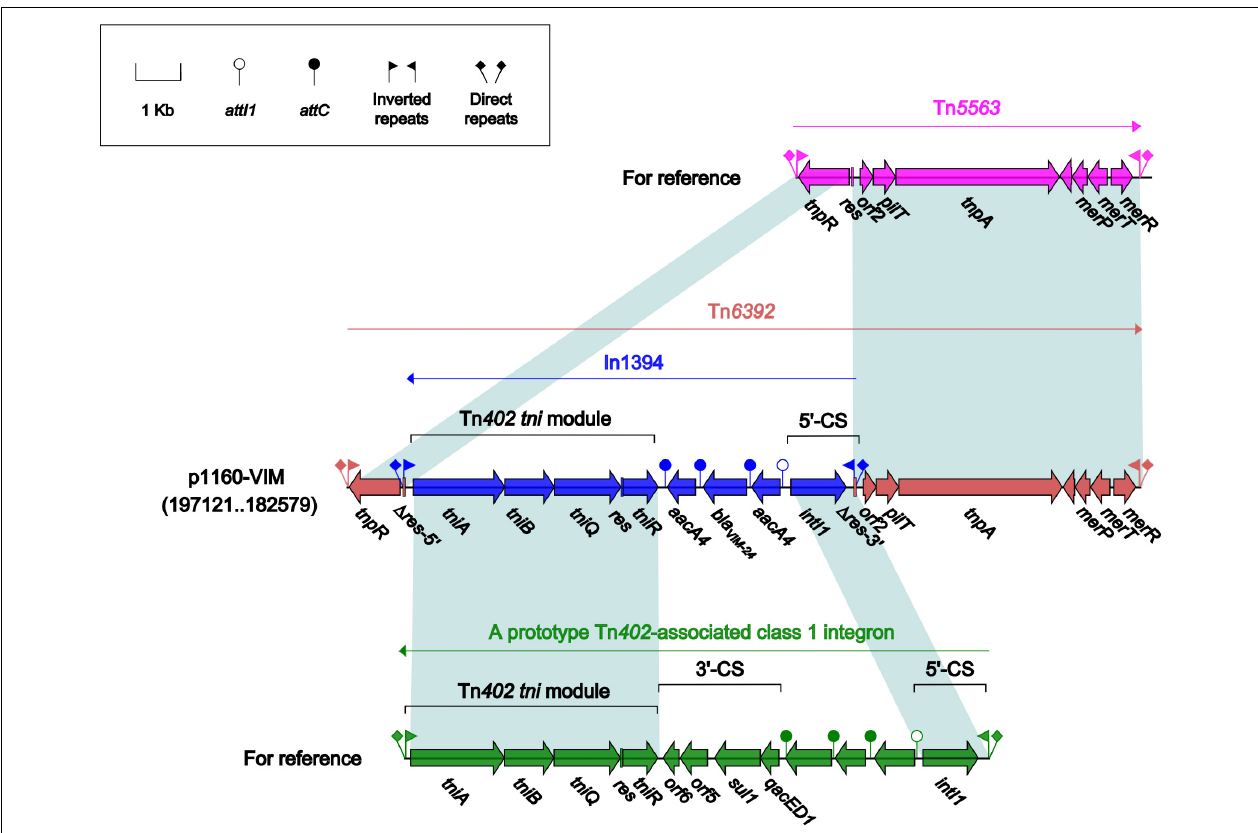
FIGURE 3 | Organization of Tn 6392 and comparison to related regions. Genes are denoted by arrows. Genes, mobile elements and other features are colored based on their functional classification. Shading denotes regions of homology (nucleotide identity > 95%). Numbers in brackets indicate nucleotide positions within corresponding plasmid sequences. Accession number of Tn 5563 for reference is